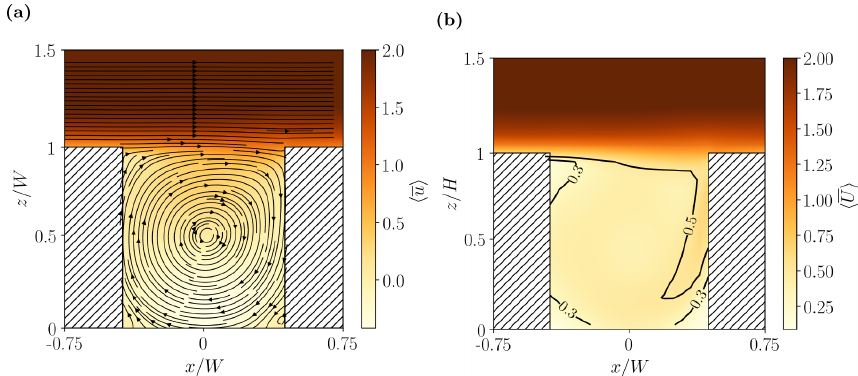
Figure 2. Spatial structure of the mean flow in the x – z plane: (a) streamwise velocity component, u (ms − 1 ); (b) wind speed, U (ms − 1